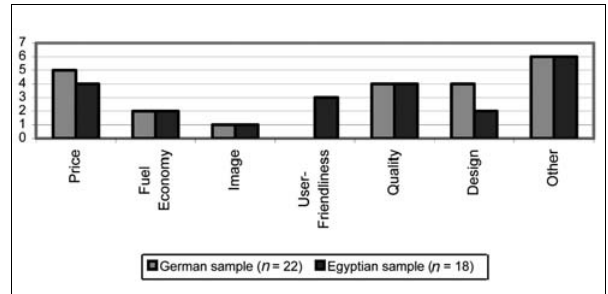
Fig 8. Reasons for choosing a car